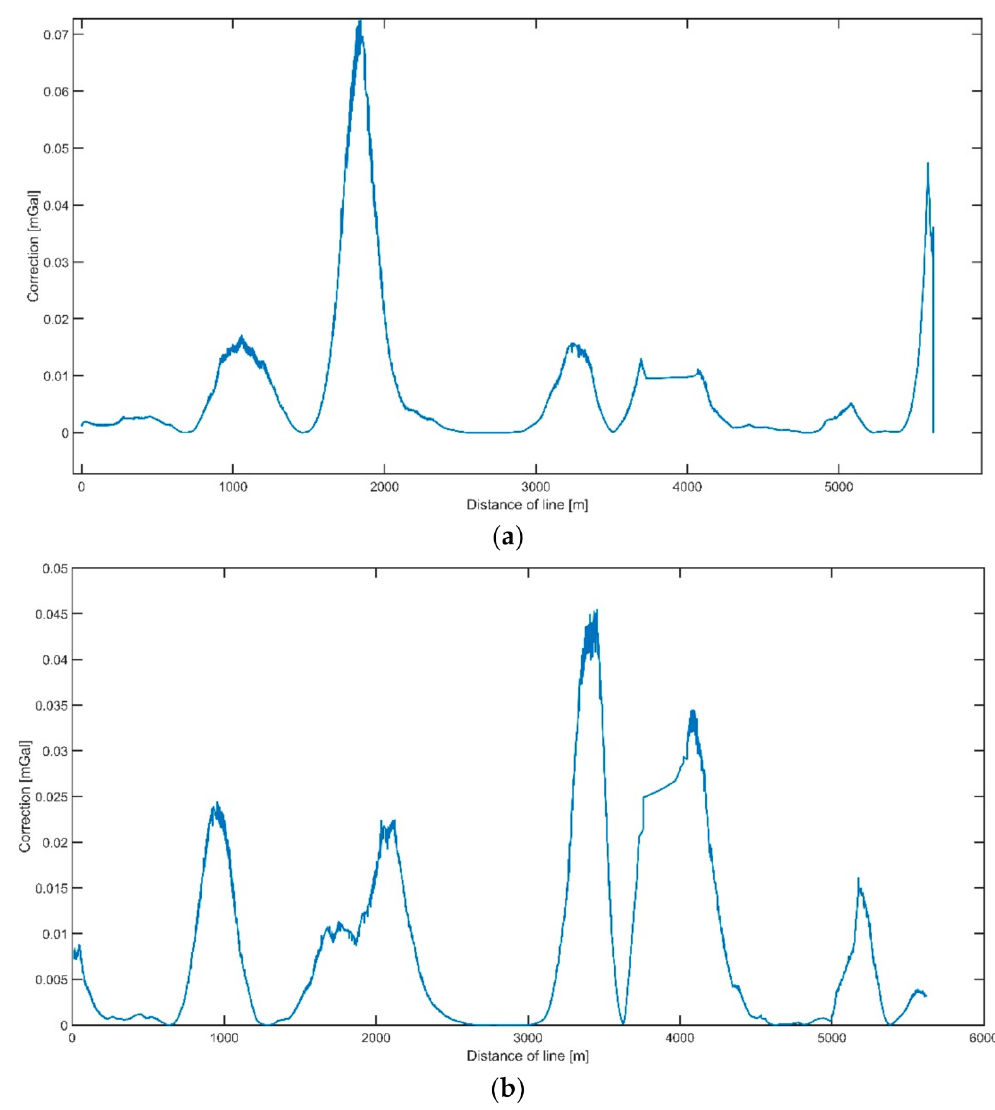
Figure 4. The distribution of the track curvature correction on the measurements of the first line ( a ) and second line ( b